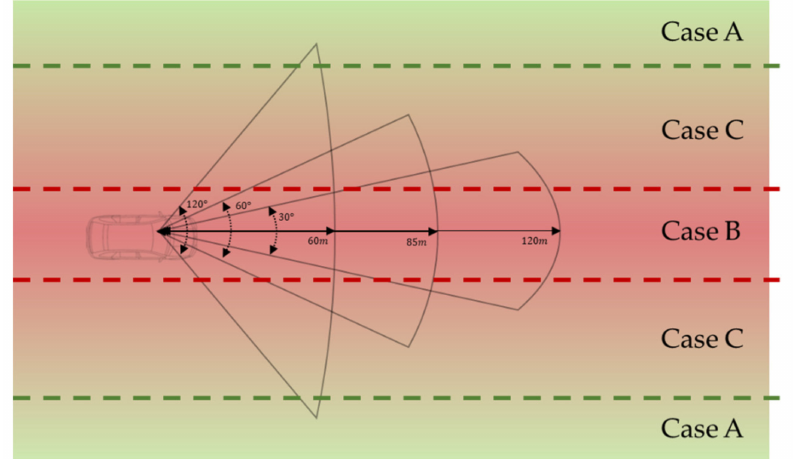
Figure 4. Classification of three cases of road conditions according to the visual perceptual degree (VPD) of a